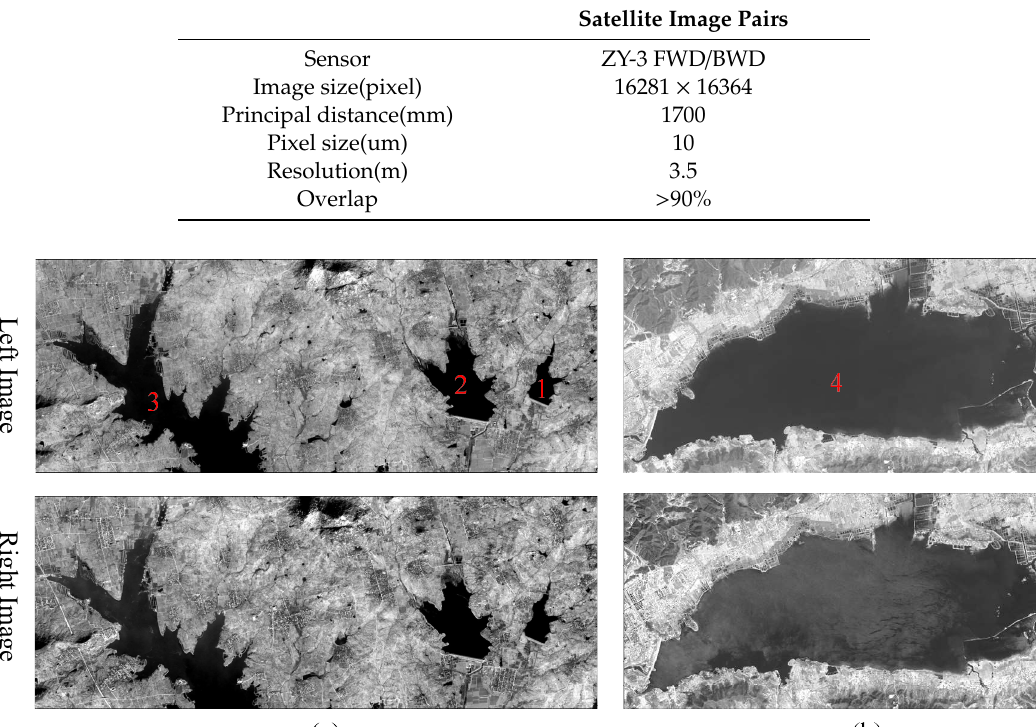
Figure 6. Experimental image pair blocks. (a) Image pair block 1. (b) Image pair block 2. Table 2. Sizes and heights of ROIs.